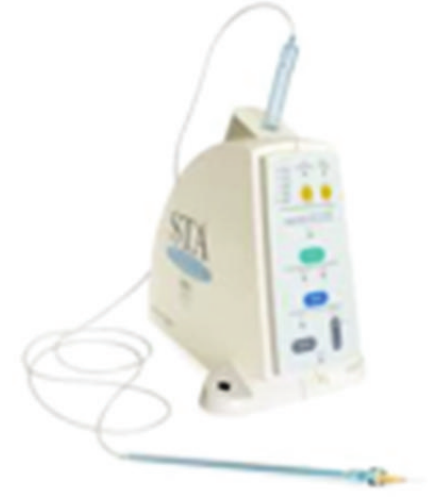
Figure 6: STA device.